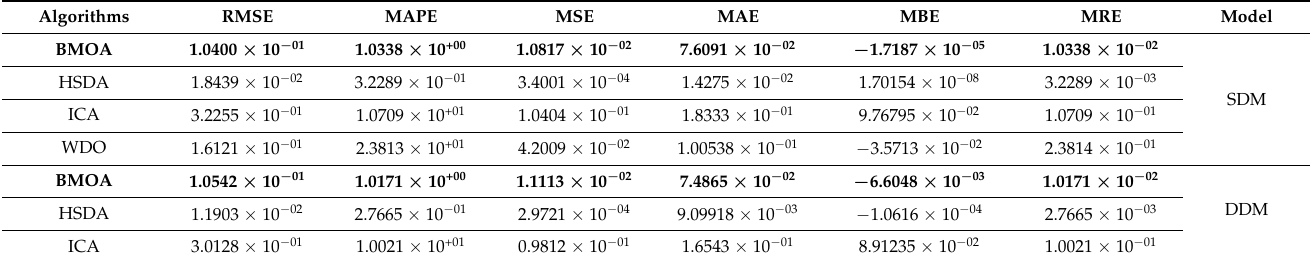
Table 19. Kyocera KC200GT photovoltaic panel (SDM and DDM) statistical